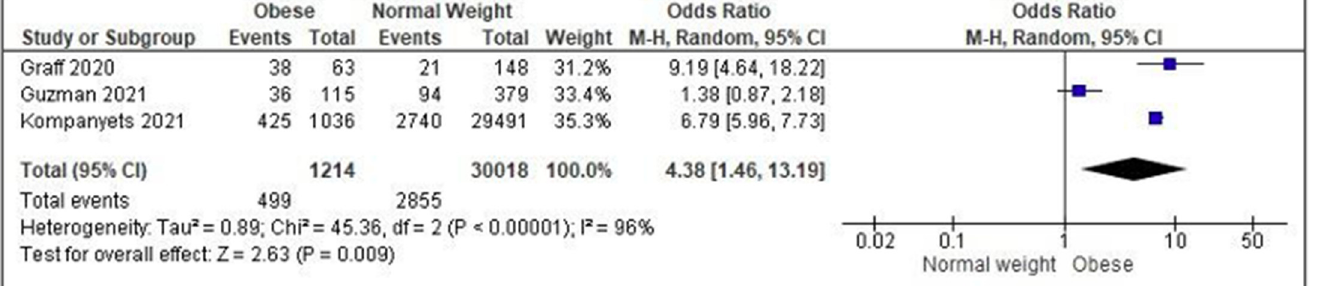
Figure 2. Meta-analysis assessing the risk of hospitalization/admission to Intensive Care Units in obese children/adolescents as compared to normal weight peers. Studies are listed in alphabetical order [36–38].